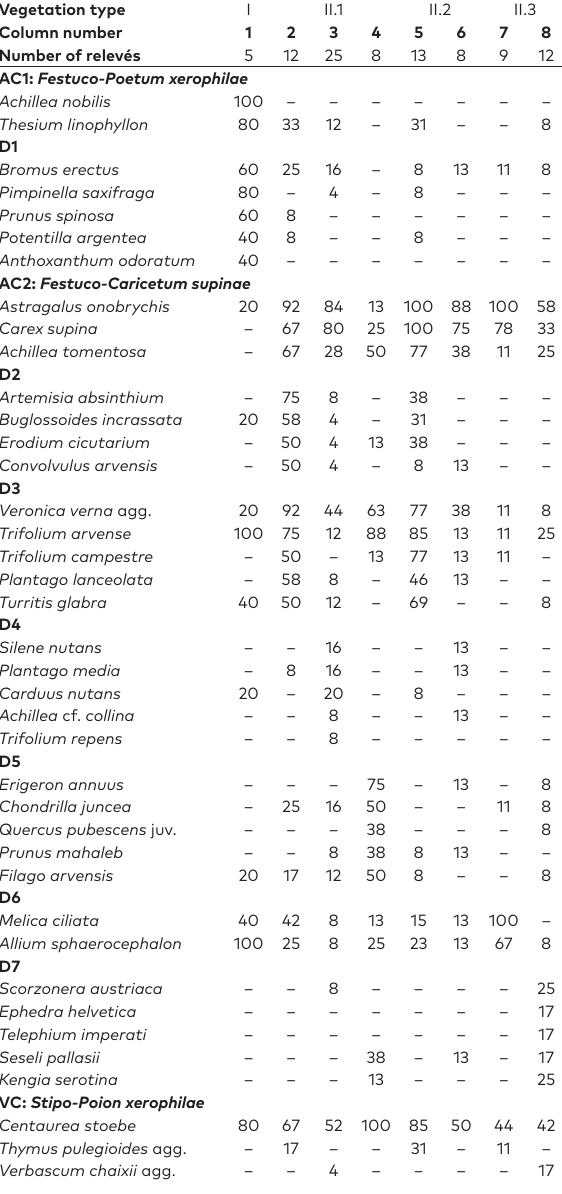
Table 1. Synoptic table of the dry grassland communities in the Vinschgau (South Tyrol, Italy) with all relevés from 2019. Values are percentage frequencies. Only companion species with frequency > 15% are stated. I = Festuco-Poe- tum xerophilae (col. 1); II = Festuco-Caricetum supinae ; II.1 = subassociation stipetosum capillatae (cols. 2–4); II.2 = sub- association bothriochloetosum ischaemi (cols. 5, 6); II.3 = subassociation stipetosum pennatae (cols. 7, 8). The name giving species Stipa capillata , Bothriochloa ischaemum and Stipa pennata agg. are indicated in bold. Variants (D1–D7, cols 2–8) were identified based on the similarity of the spe- cies composition: Veronica verna -variant (cols. 2, 5), typical variant (cols. 3, 6, 8), species-poor variant (col. 4), Melica ciliata -variant (col. 7). Abbreviations: AC = association character species, agg. = aggregate, cf. = confer (means ‘compare’), juv. = juvenile, KC = class character species,